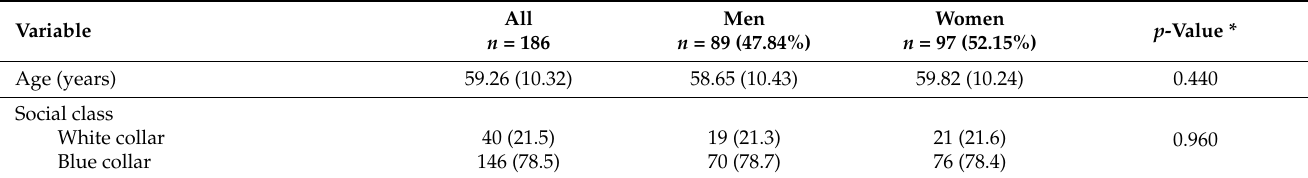
Table 1. Anthropometric characteristics and biochemical parameters of the study population, overall and according to